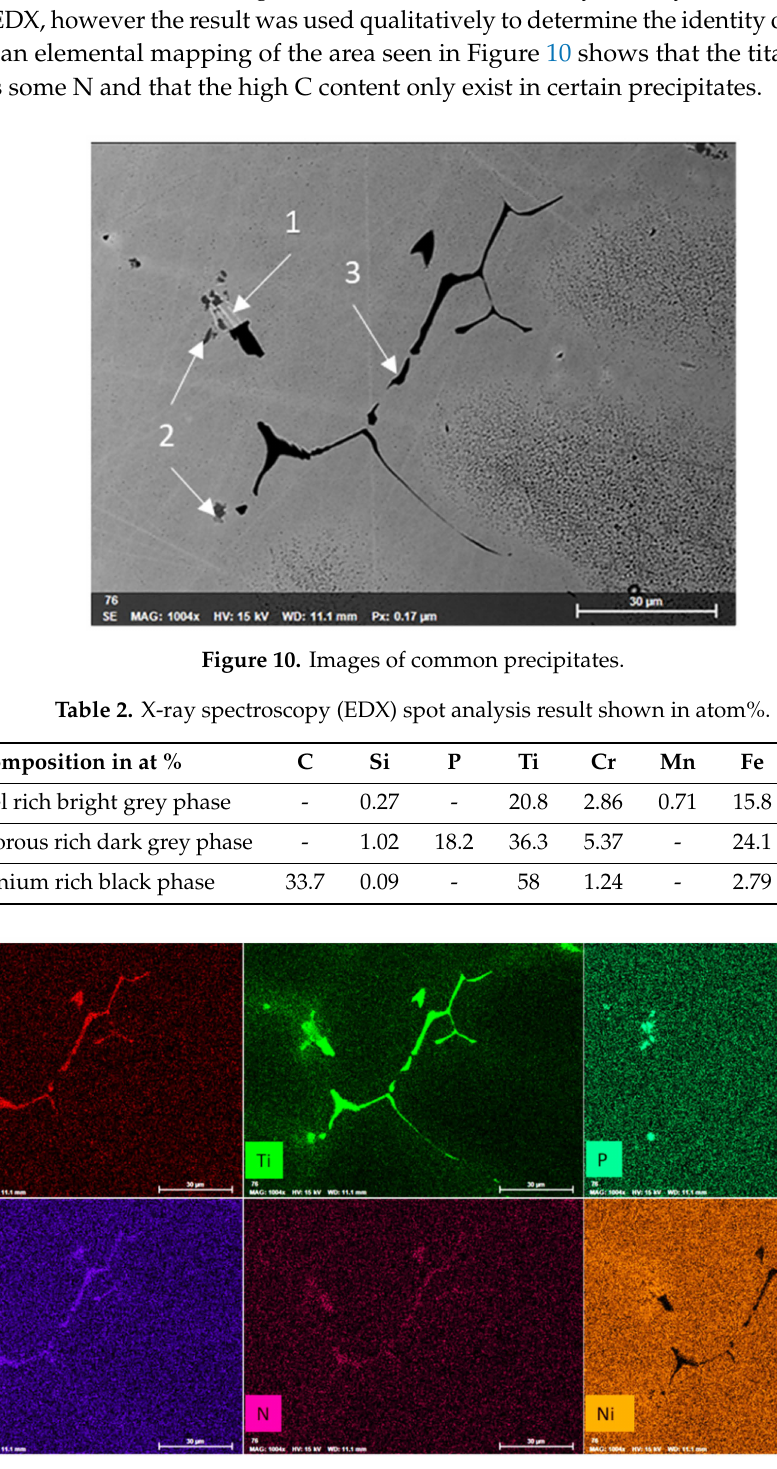
Figure 11. Elemental mapping of C, Ti, P, Mo, N, and Ni content in